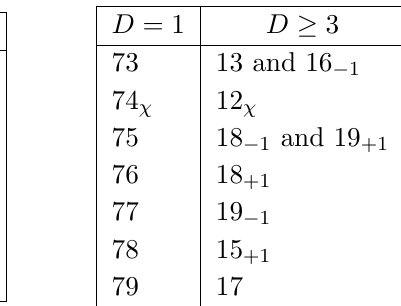
Table 13 . Correspondence between D = 1 and D (cid:21) 3 Lie